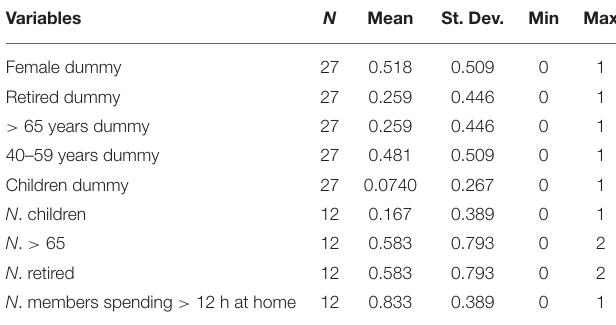
TABLE 1 | Descriptive characteristics of